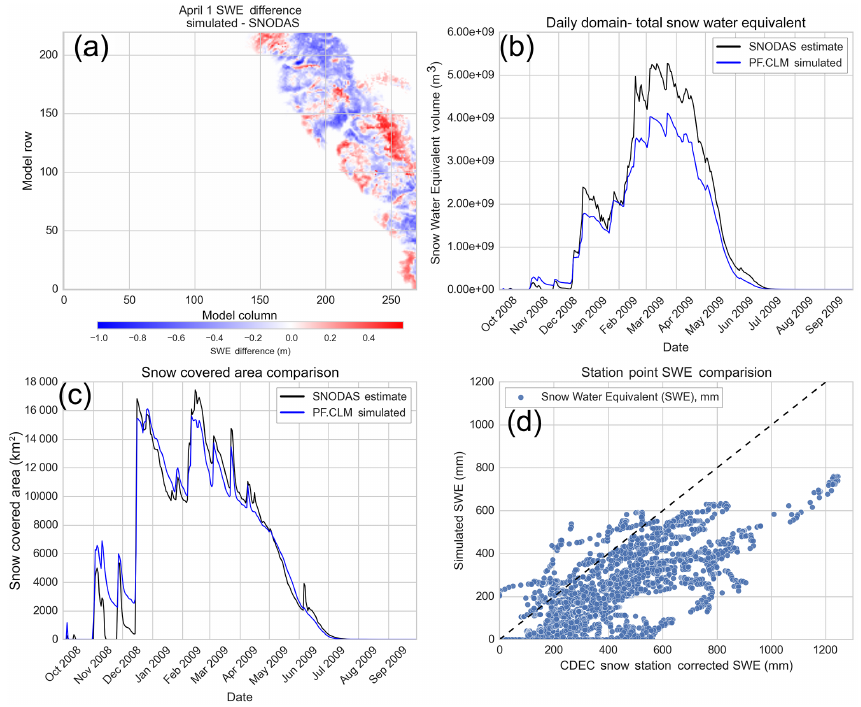
Figure 4. Comparisons between simulated and observed snow water equivalent (SWE) snow covered area. (a) SJBM simulated 1 April SWE minus the SNODAS product. (b) Daily domain-total-simulated (SJBM) and observed (SNODAS) SWE. (c) Daily domain-total- simulated (SJBM) and observed (SNODAS) snow covered area. (d) Point SWE comparisons for winter 2008–2009, simulated (SJBM) vs. observed (California Department of Water Resources snow